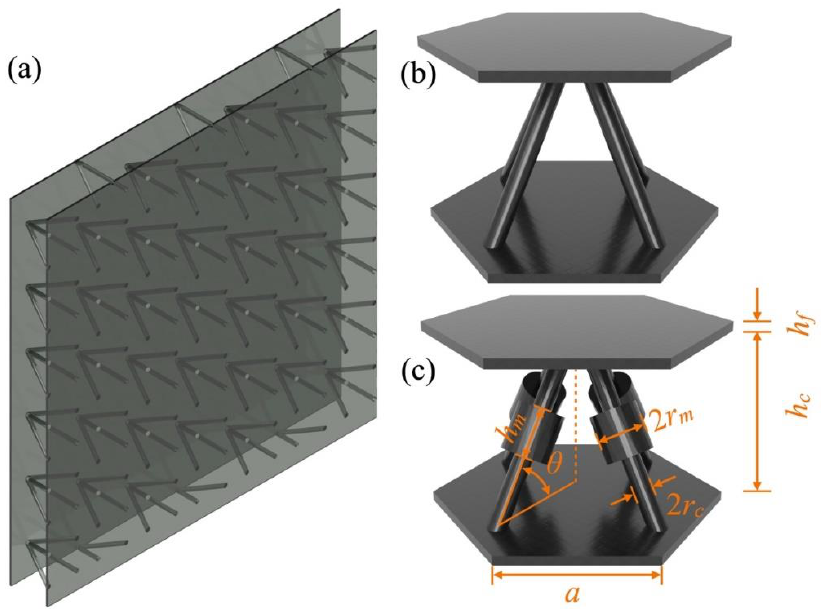
Figure 1. ( a ) Typical lattice sandwich plate, ( b ) typical lattice sandwich unit cell, ( c ) SPLCRR unit-cell.